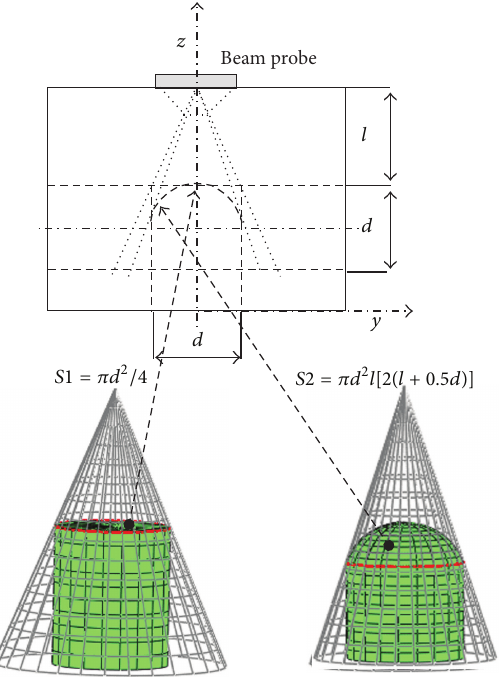
Figure 5: The reflector surfaces 𝑆1 and 𝑆2 which are surrounded by aredlinerelatingtoflatbottomholeandhemisphericalbottomhole, respectively.